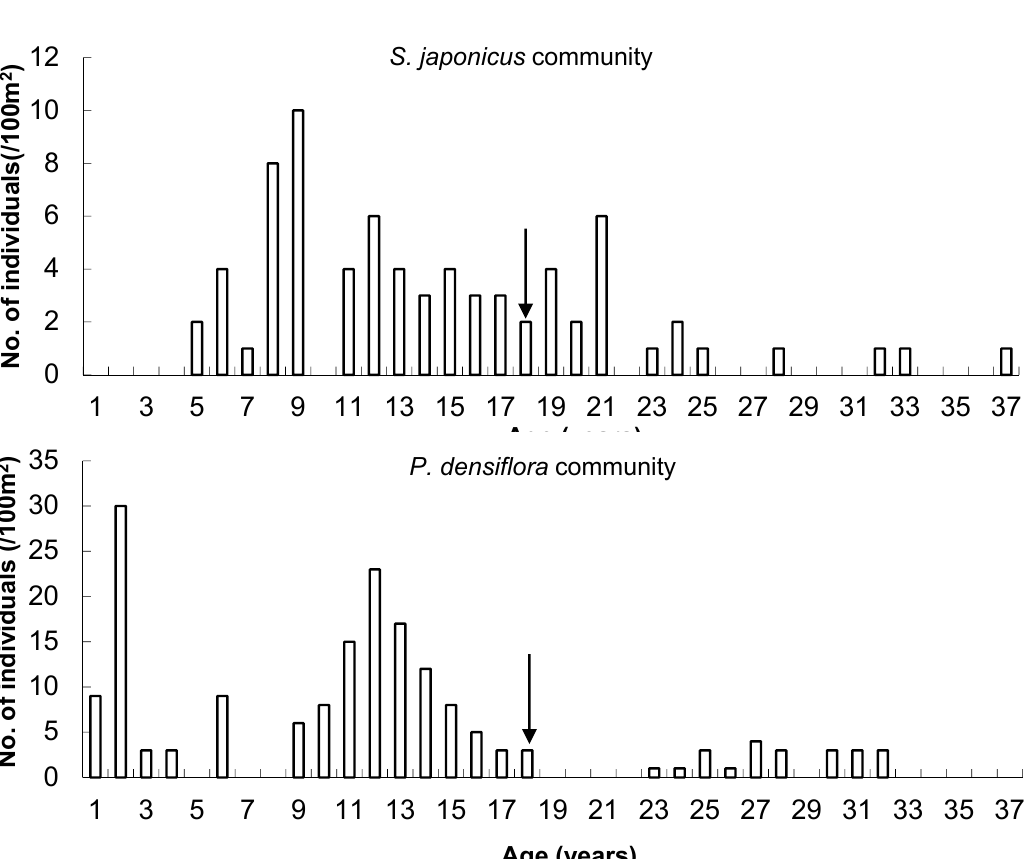
Figure 6. Age distribution diagrams of two woody plant communities, S. japonica community and P. densiflora communities, established around the Yeocheon industrial complex. Arrow indicates the year that the industrial facility in this area began to operate in this area.